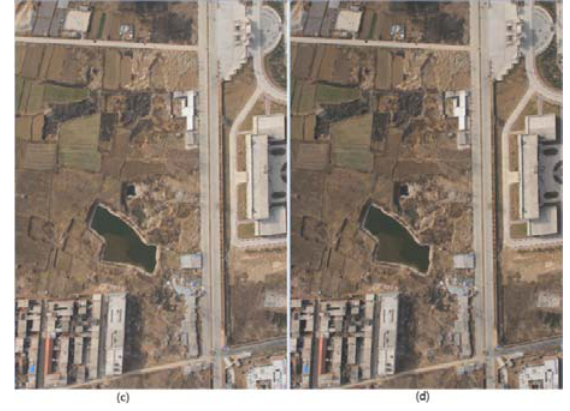
Figure 1. Two pairs of epipolar images. 3.1 The results calculated by the proposed algorithm. In these experiments, parameters D 1 , D 2 , bund , J 1 and J 2 are all set to 80, 255, 15, 0.85 and 0.75 based on our experimental experiences. The maximum research range for reference pixels in both two epipolar image pairs is 60 pixels. After combining all the disparities of the pixels in the reference images, two disparity space images (DSI) with the same resolution as the reference images was generated as shown in Figure 2 (pixel’s gray value = reference pixel’s disparity *